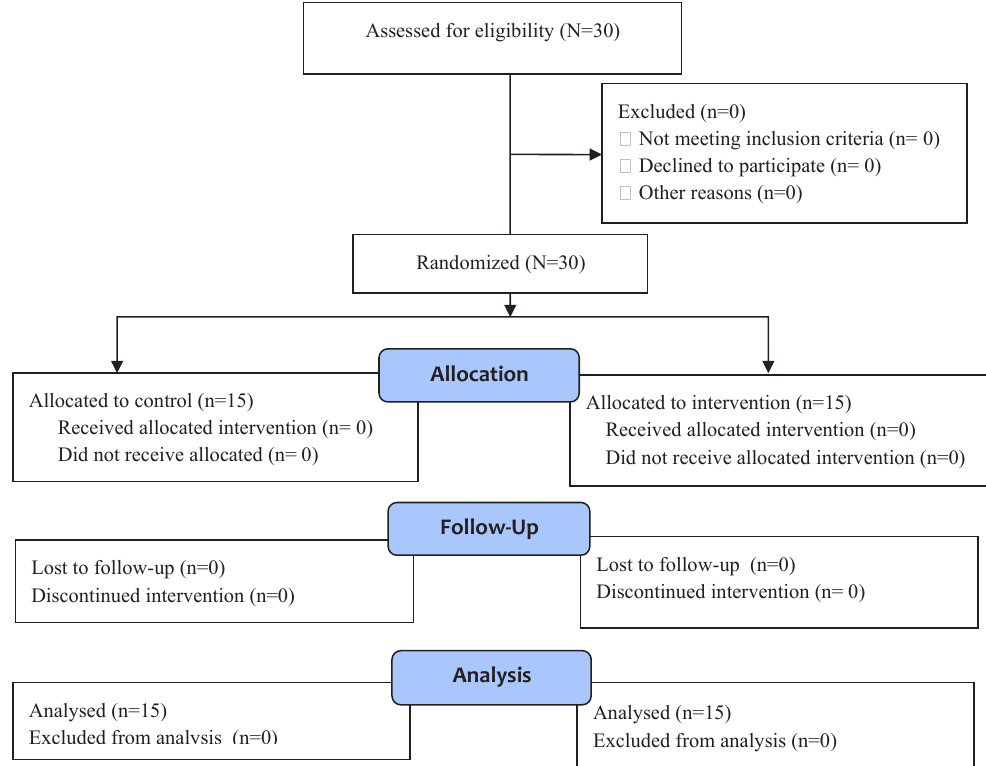
Figure 1. CONSORT flow diagram of the study